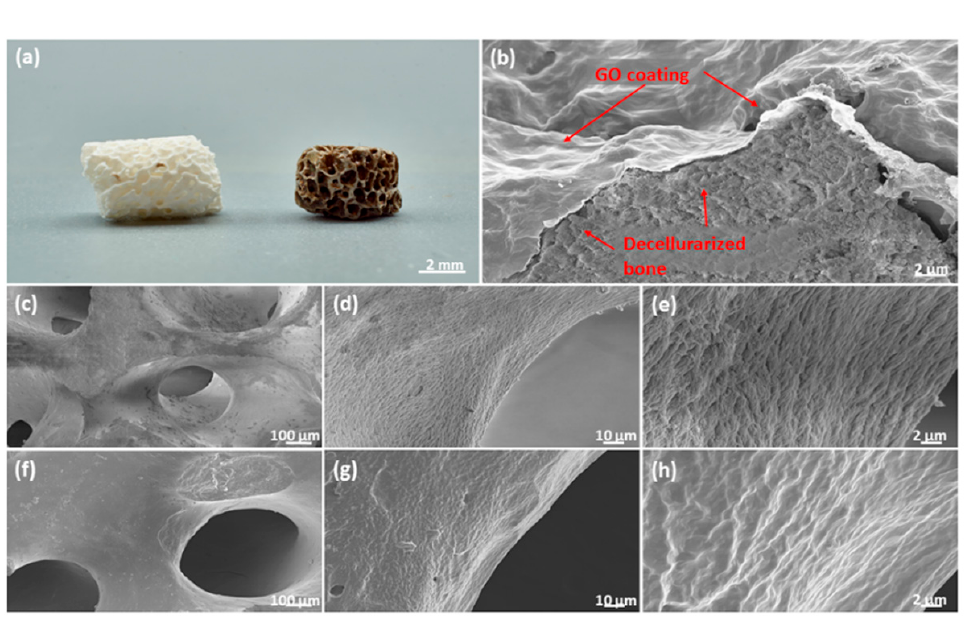
Figure 4. Graphene Oxide Coated Bio-Oss ® . ( a ) Photograph of uncoated (left) and GO coated (right) Bio-Oss ® scaffold. ( b ) SEM micrograph of broken GO coated Bio-Oss ® scaffold with highlighted GO layer. ( c – e ) SEM micrographs of uncoated Bio-Oss ® scaffold in different magnifications, ( f – h ) SEM micrographs of GO coated Bio-Oss ® scaffold in different magnifications.